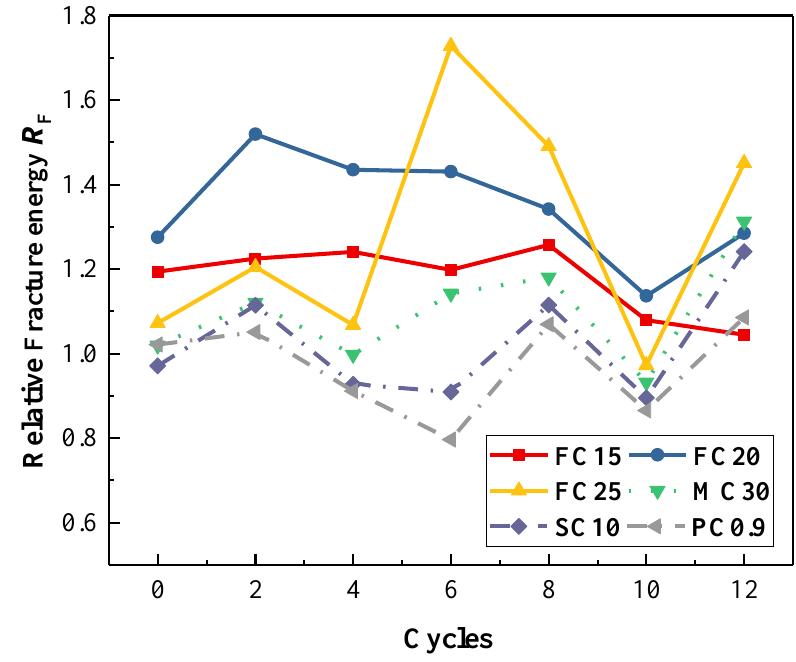
Figure 8. Evolution of relative fracture energy.